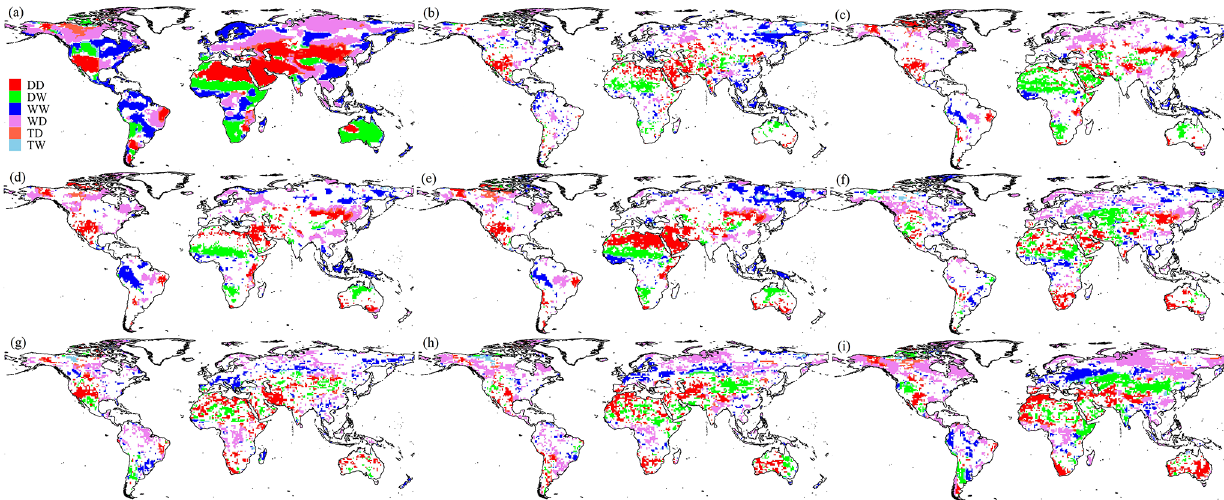
Figure 3. Global assessment of the DDWW paradigm based on TWS-DSI during the (a–f) historical (1985–2014) and (g–i) future (2071– 2100) periods under (g) SSP126, (h) SSP245, and (i) SSP585 scenarios. Note that the historical results are based on the (a) GRACE recon- struction, (b) WGHM, (c) VIC, (d) CLSM, (e) Noah, and (f) ensemble mean of eight GCMs, respectively. The future results are based on the ensemble of eight GCMs. DD indicates the dry gets drier, DW indicates the dry gets wetter, WW indicates the wet gets wetter, WD indicates the wet gets drier, TD indicates the transition gets drier, and TW indicates the transition gets wetter.